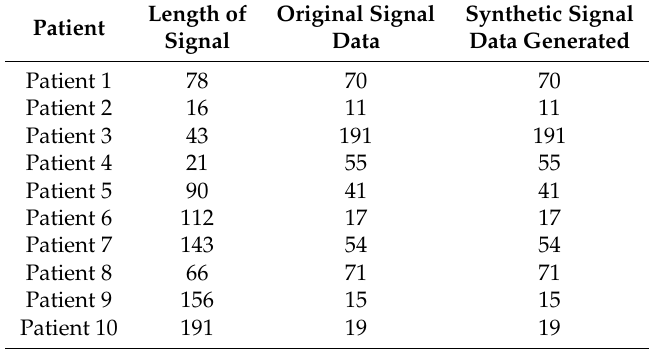
Table 7. Details of Synthetic Electromyography (EMG) Signals